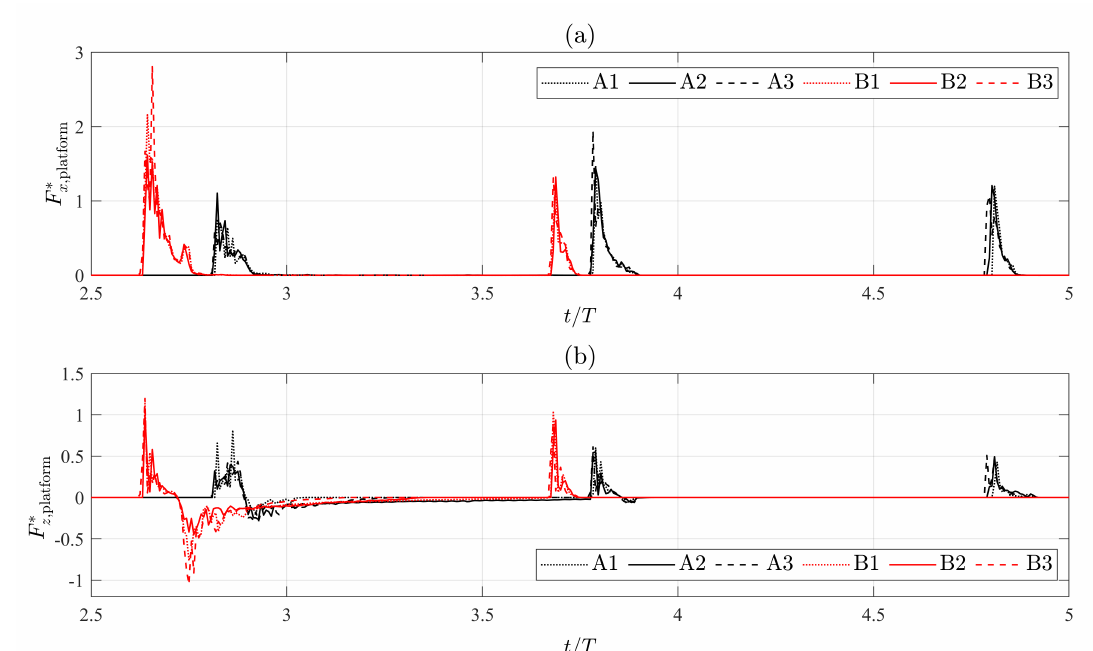
Figure 9. Time history of the normalized ( a ) horizontal and ( b ) vertical forces on the pier platform for different tested wave conditions.